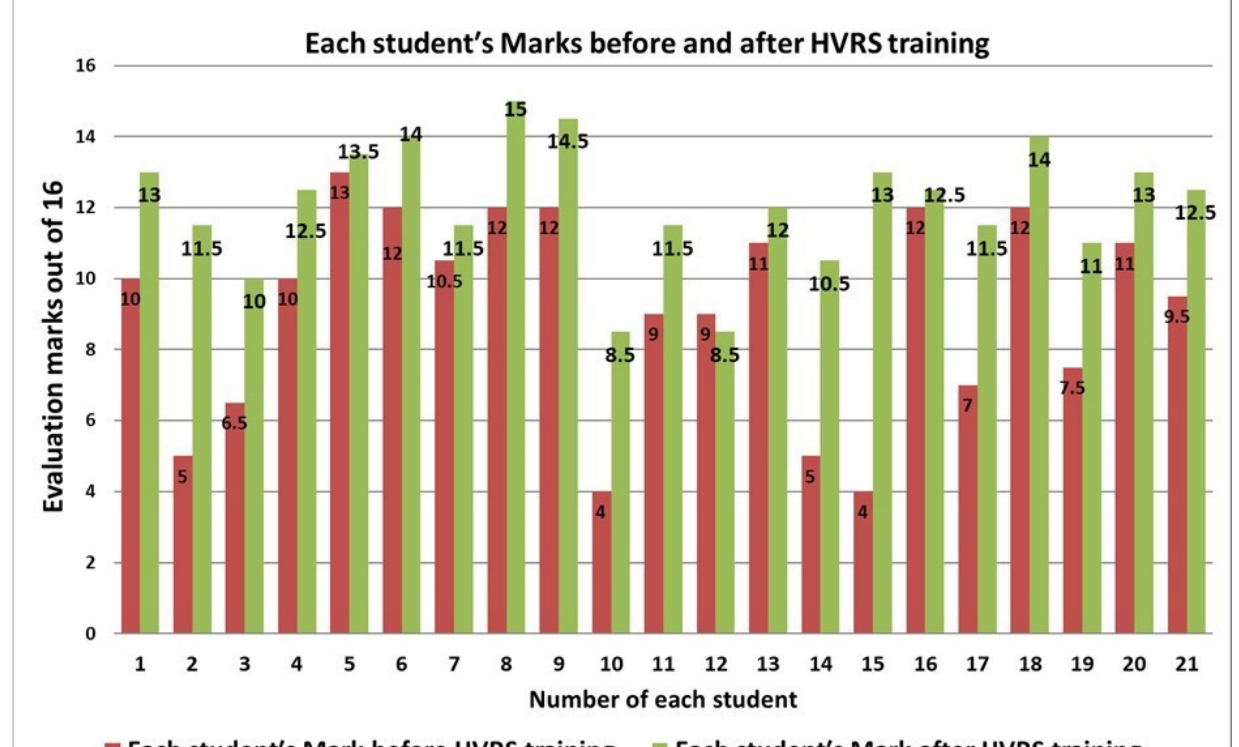
Figure 3. Each Student total mark before and after HVRS training.